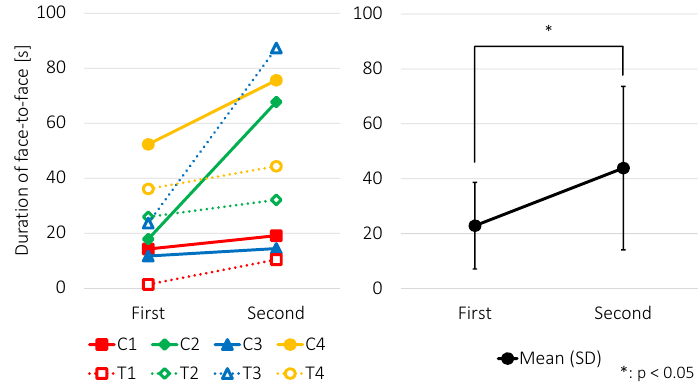
Figure 11. ( Left ) Total durations of face-to-face behavior in each participant for the two periods; and ( Right ) the means with standard